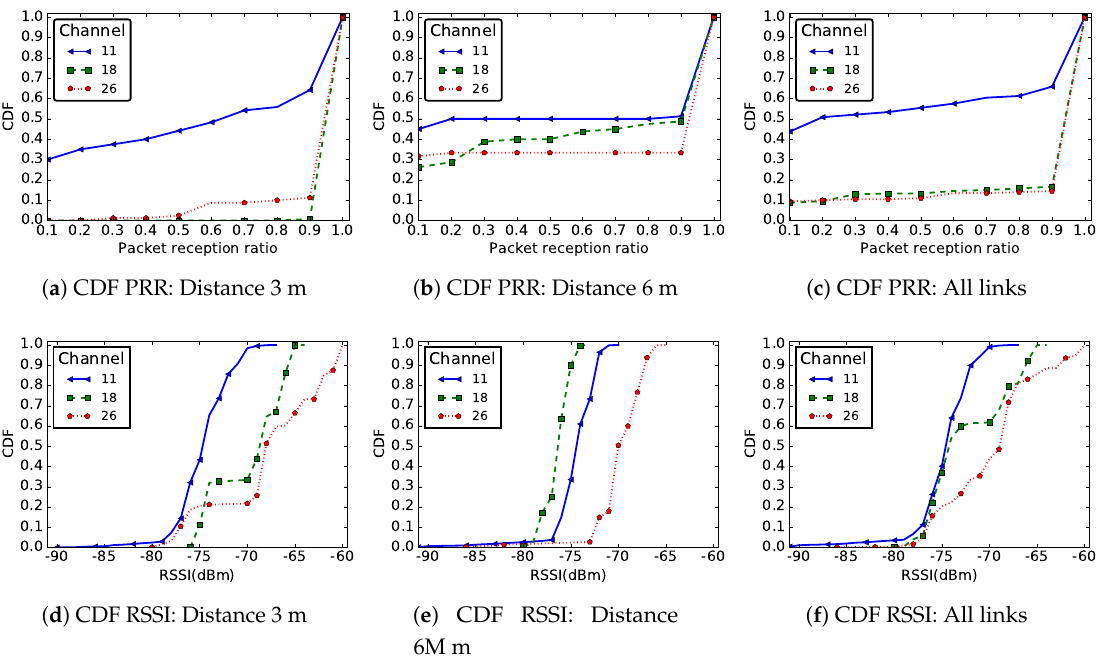
Figure 10. CDF of PRR and RSSI for distances 3 m and 6 m and for all links in the network, for different communication channels.